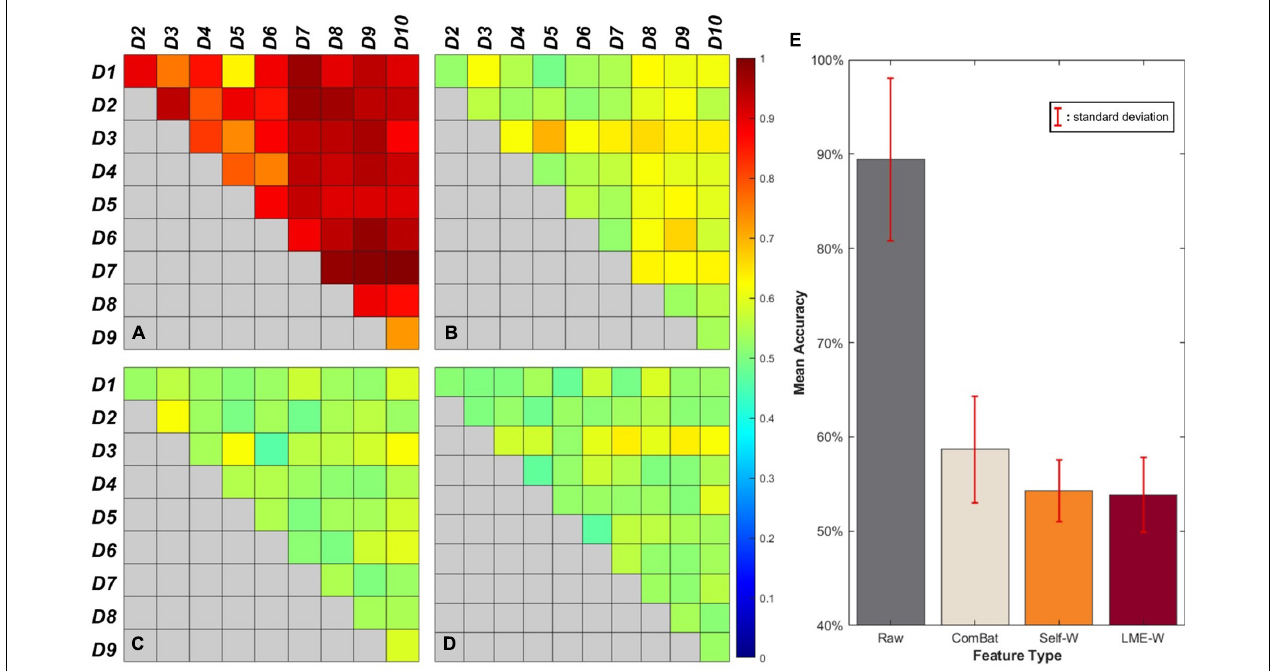
FIGURE 2 | Visual results of binary classification using different harmonization methods. Each cell of the box represents the accuracy of center-wise classification results carried out by (A) Raw, (B) ComBat, (C) Self-W, and (D) LME-W. Mean accuracy and standard deviation classification results of each harmonization scores are described as bar graphs at (E)